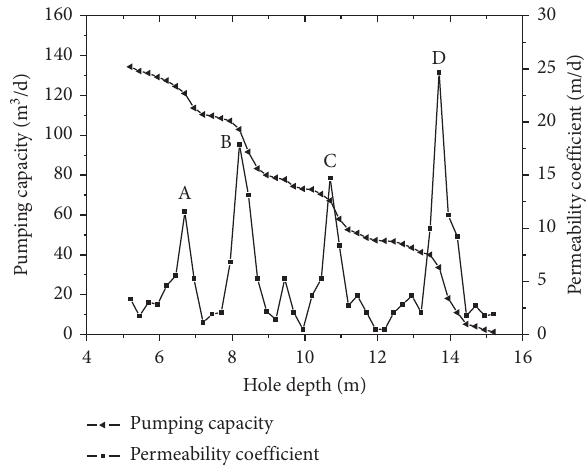
Figure 5: Distribution curves of the pumping capacity and per- meation coefficient with the pumping hole depth.